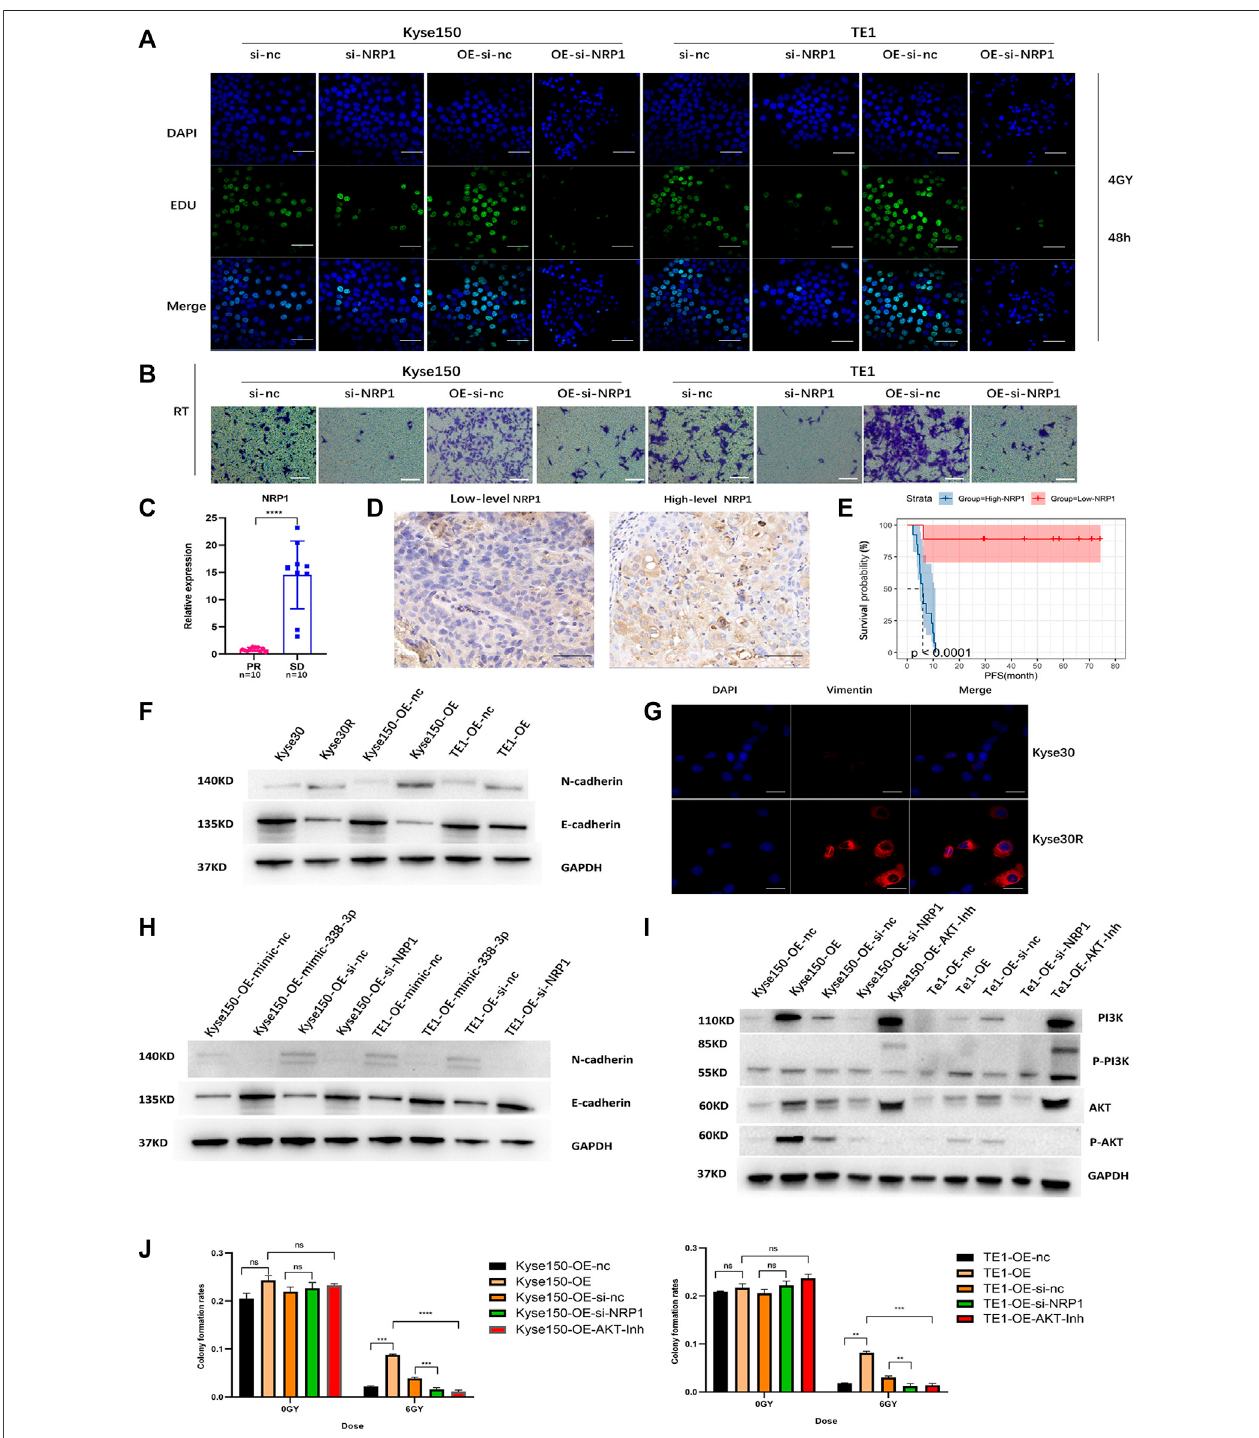
FIGURE 5 | Circ-0007022 activates EMT and PI3K/AKT pathway by regulating the miR-338-3p-NRP1 axis, leading to radio-resistance of ESCC cells. (A,B) EDU assay (Green, EDU staining; Blue, DAPI nuclear staining; Scale bar 50 μ m) and Transwell assays (Scale bar 50 μ m) assessed cell migration and proliferation abilities of Kyse150, TE1, Kyse150-OE and TE1-OE cells, transfected with NRP1 siRNAs, after radiotherapy. (C) The qRT-PCR detected the expression level of NRP1 in tumor tissues of patients. (D) Immunohistochemical staining image of NRP1 was acquired on tumor tissues from High/Low level group (Scale bar 50 μ m). (E) Kaplan- Meier analysis showed that the level of NRP1 was predictive of PFS in ESCC patients receiving radiotherapy (PFS, progression-free survival). (F,G) Western blot and Immuno fl uorescence (Red, Vimentin staining; Blue, DAPI nuclear staining; Scale bar 30 μ m) analyzed expression change of EMT-related proteins